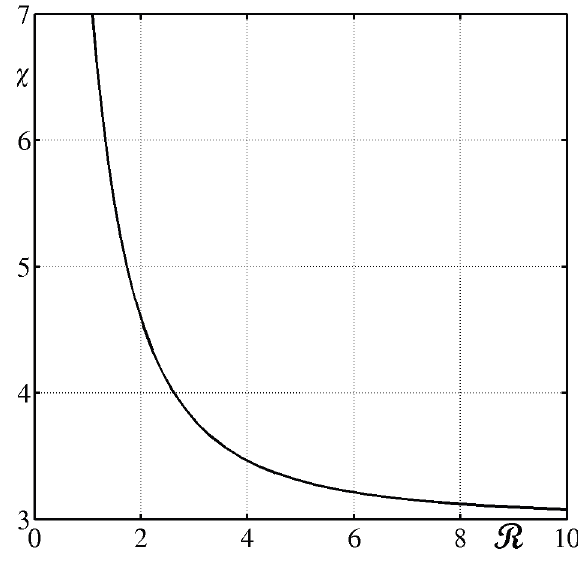
Figure 5. Value of χ for Equation (27) as a function of the dimensionless wavelength R